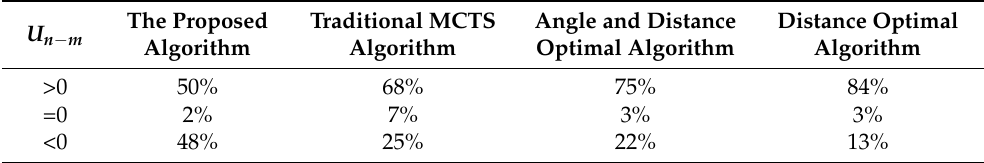
m compared to 0. −